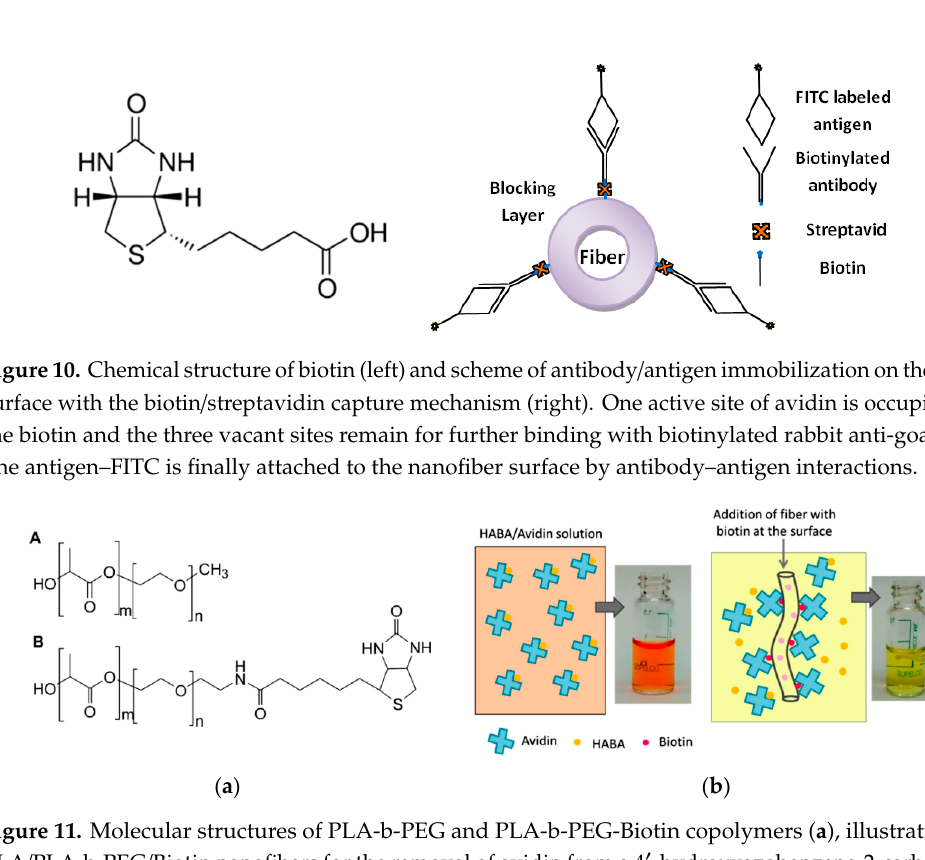
Figure 9. Scheme of the surface modification of electrospun PSU nanofibers with CB.